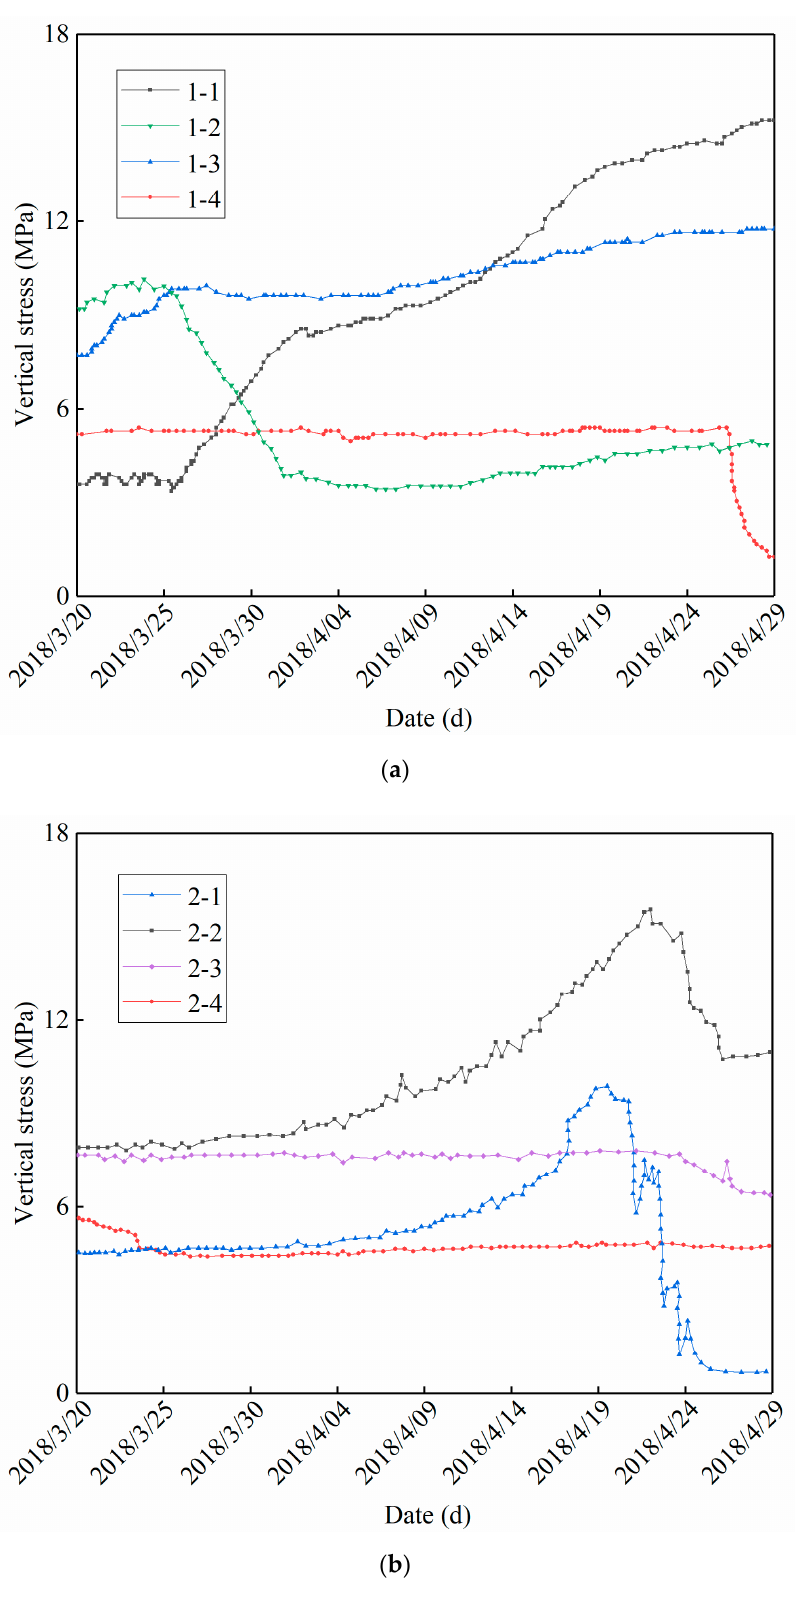
Figure 18. Relative vertical stress variation curve. ( a ) Relative vertical stress variation curve of station 1; ( b ) Relative vertical stress variation curve of station 2. 1; ( b ) Relative vertical stress variation curve of station